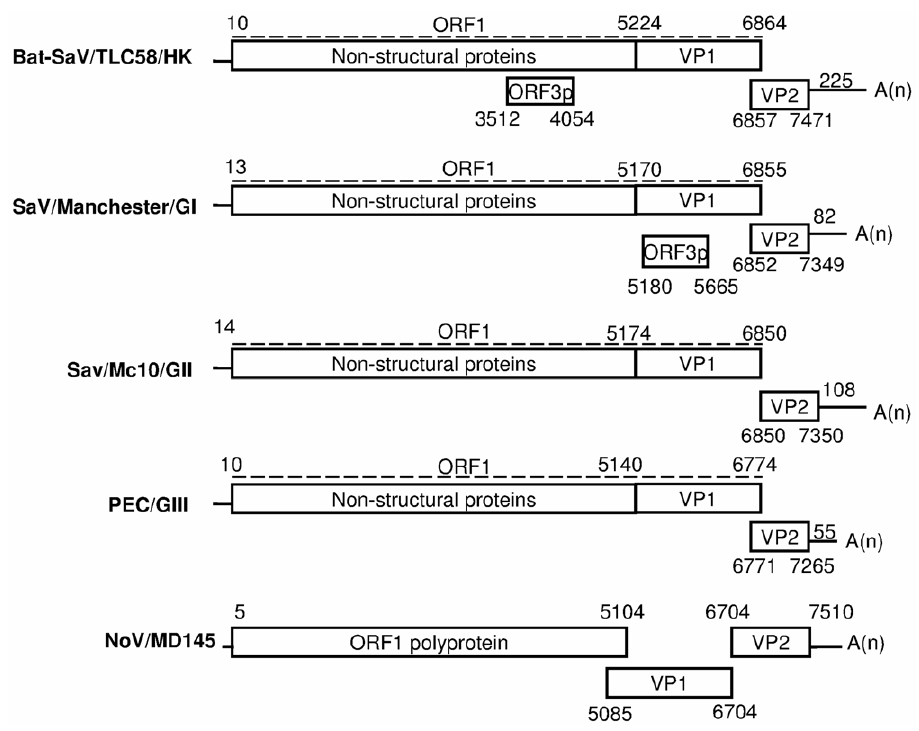
Figure 1. Genome organization of the bat SaV TLC58/HK. The genome organization of the bat SaV TLC58/HK in comparison with the genome organization of human SaV GI strain Mancheseter, human SaV GII strain Mc10, porcine enteric calicivirus, and norovirus GII strain MD145.